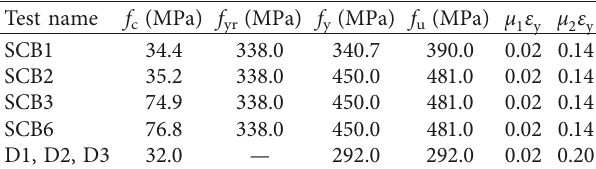
Table 2: Material properties for experimental studies [11,